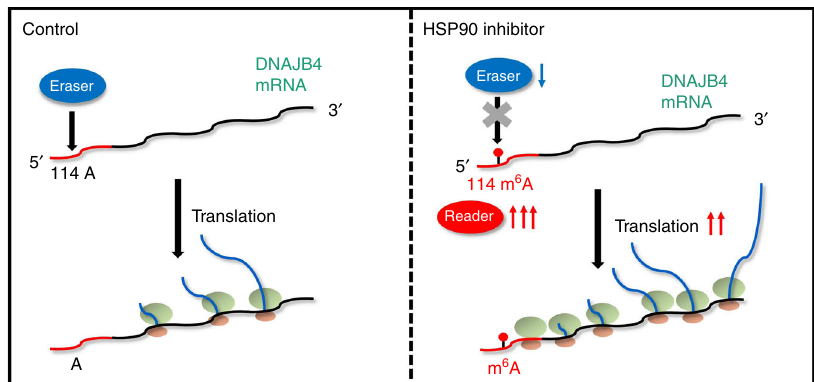
Fig. 8 An m 6 A-based regulatory mechanism of DNAJB4 translation. Shown is a schematic diagram for the HSP90 inhibitor-induced translational upregulation of DNAJB4 through an m 6 A-mediated epitranscriptomic mechanism. 5 ′ -UTR of DNAJB4 mRNA is marked in red and the rest of the mRNA is in black. The red dot on the DNAJB4 mRNA represents the methylation on adenosine. The green and pink circles on the DNAJB4 mRNA represent the large and small subunits of ribosome, respectively. The blue lines coming out of ribosome represent newly synthesized DNAJB4